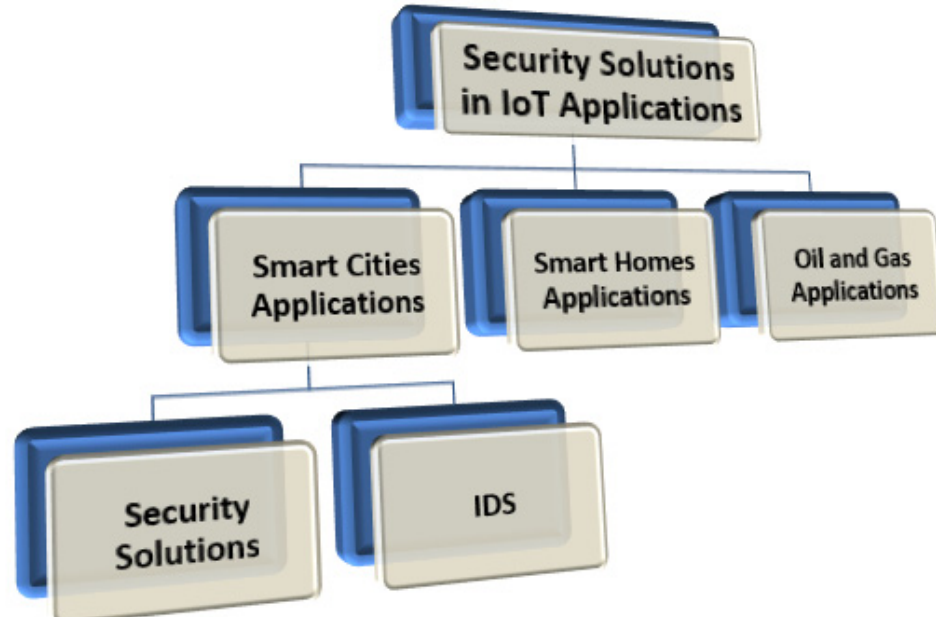
Figure 5. Security solutions in IoT applications.